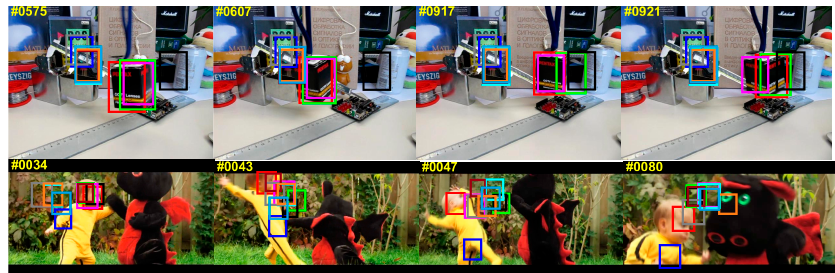
Table 4. Overlap accuracy and average accuracy of representative ten trackers in 11 different attributes. Red, green, and blue, respectively, represent the top three trackers. Trackers